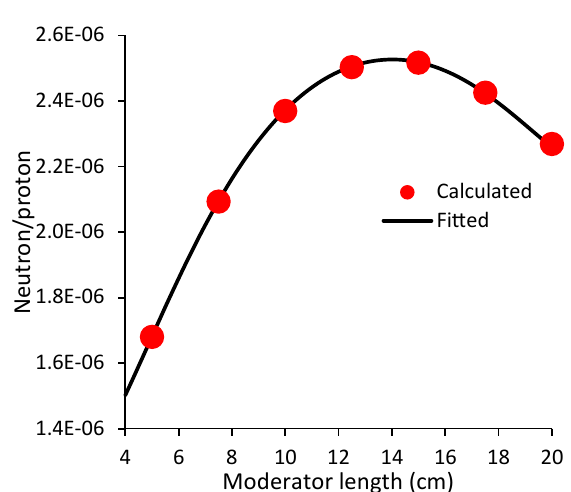
Fig. 2 . CN production versus moderator length in CNS.